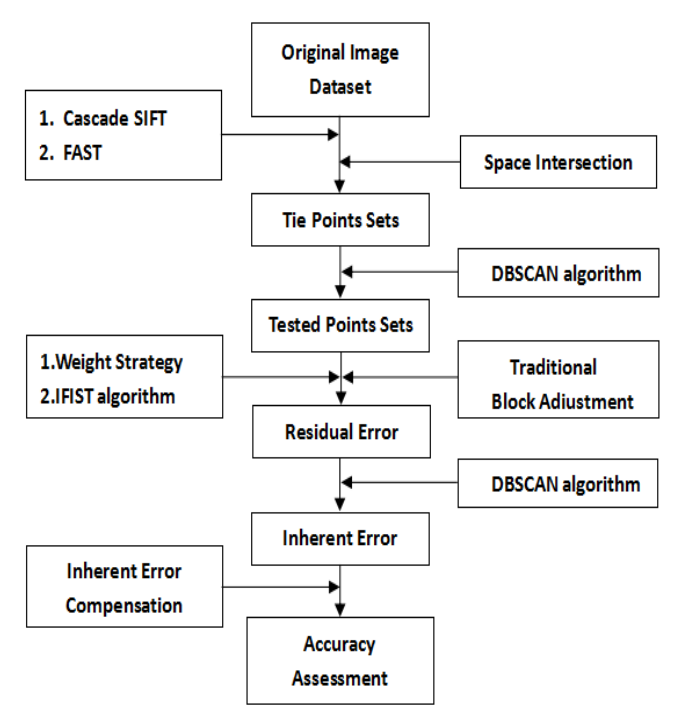
Figure 1. Flow chart of our proposed method. DBSCAN: density-based spatial clustering of applications with noise; FAST: features from accelerated segment test; IFIST: improved fast iterative